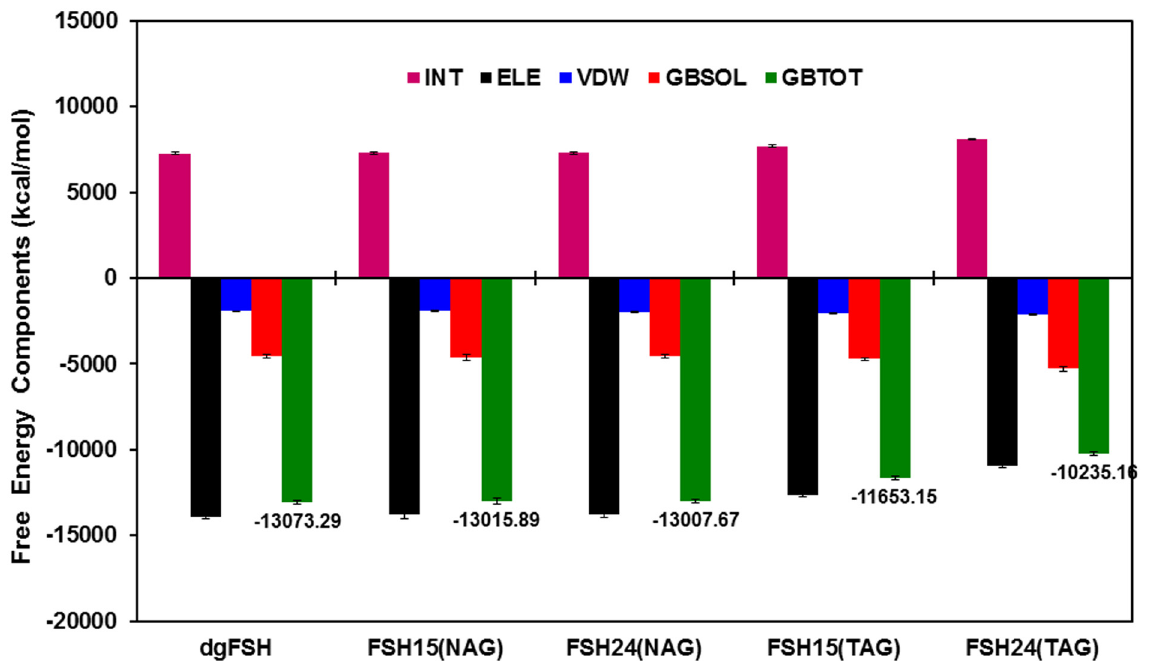
Fig 10. Energy components (kcal/mol) for the binding of FSH/FSHR in different systems like the dgFSH, FSH 15 (NAG), FSH 24 (NAG), FSH 15 (TAG), and FSH 24 (TAG): INT: Internal energies arising from bond, angle, and dihedral terms, ELE: Electrostatic energy in the gas phase; VDW: van der Waals energy; GBSOL: sum of polar and non-polar solvation energies; GBTOT: Total binding free energies. Error bars shown in black solid line specifies the difference in terms of standard deviations.